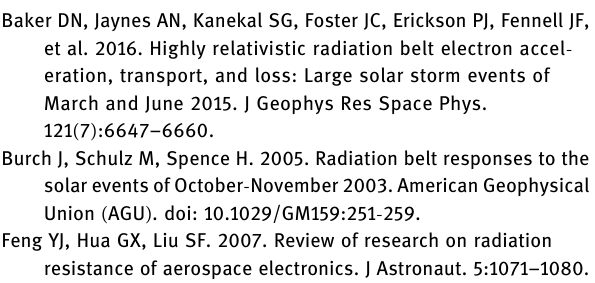
Table 2: The fl ux error of the HEPD Electronic count error Error